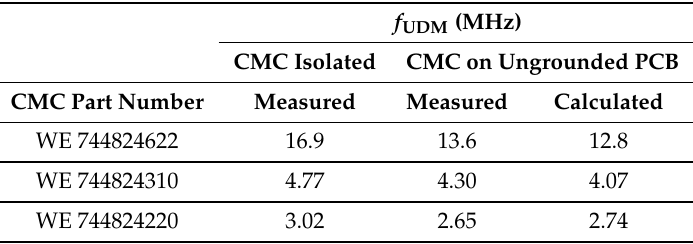
Table 3. Measured frequencies of resonance of S UDM for three CMCs when isolated and when mounted 21 on a PCB with an ungrounded return plane. Also, calculated f UDM for the latter case. f UDM (MHz) CMC Isolated CMC on Ungrounded PCB CMC Part Number Measured Measured Calculated